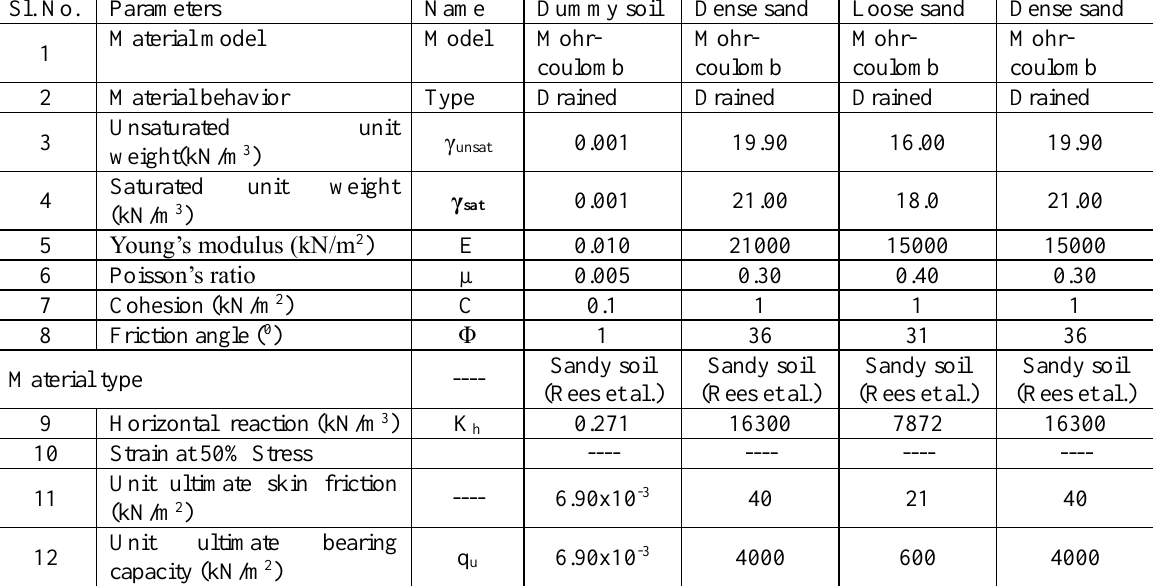
Summarizes the material (ground) properties used in the analyses. Sl.